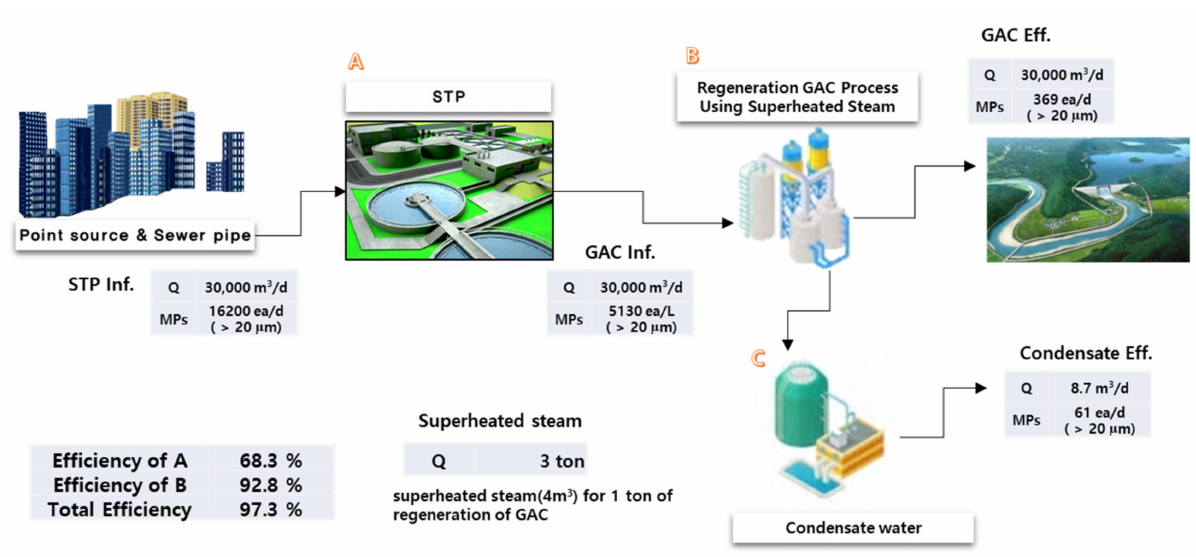
Figure 8. Estimated mass flow of MPs in the suggested sewage treatment system (based on Q = 30,000 m 3